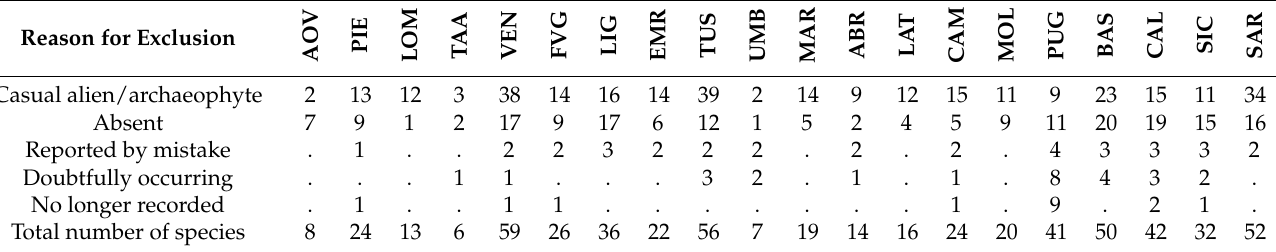
Figure 7. Number of recorded Wild Edible Plants (WEPs) by geographical sector and percentage comparison with regional flora. The taxa excluded from the calculation, according to the status defined by [60] (casual alien, absent, doubtfully occurring, reported by mistake, no longer recorded) and updated to date according to [61] are reported, region by region, in Table 5.